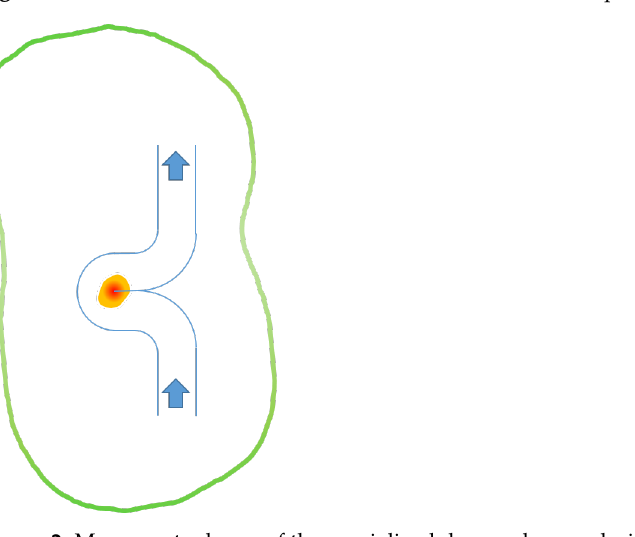
Figure 2. Movement scheme of the specialized drone when exploring a potentially hazardous object or